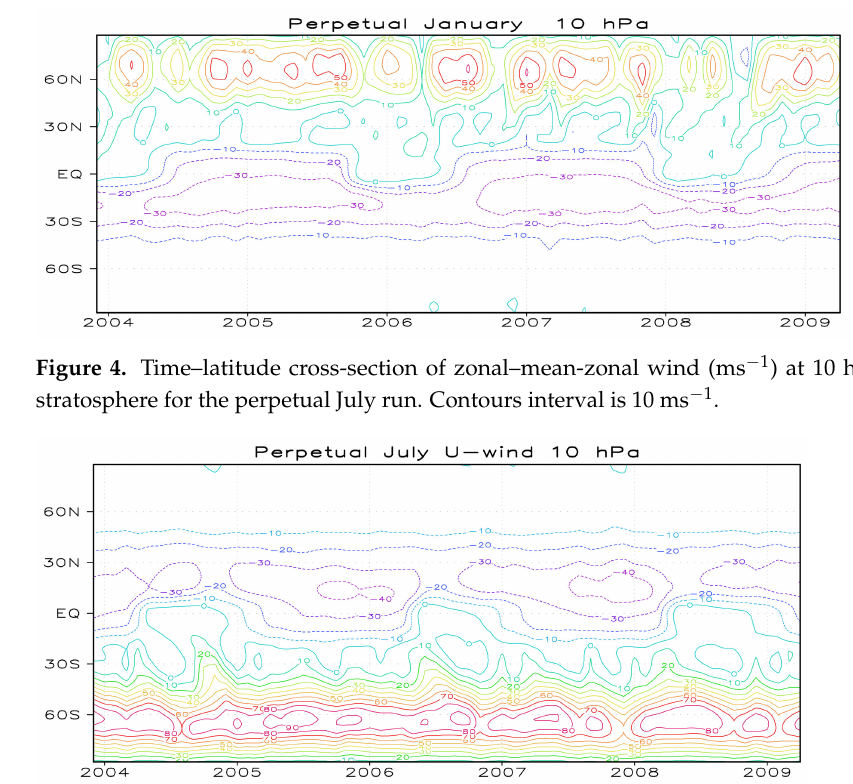
Figure 5. Time–latitude cross-section of zonal–mean-zonal wind (ms − 1 ) at 10 hPa in the upper stratosphere for the perpetual January run. Contours interval is 10 ms − 1